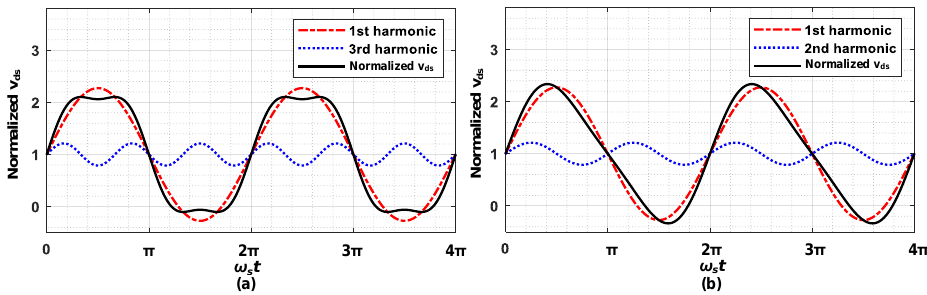
Figure 2. Switch voltage with different harmonics: ( a ) 1st and 3rd harmonics; ( b ) 1st and 2nd harmonics.